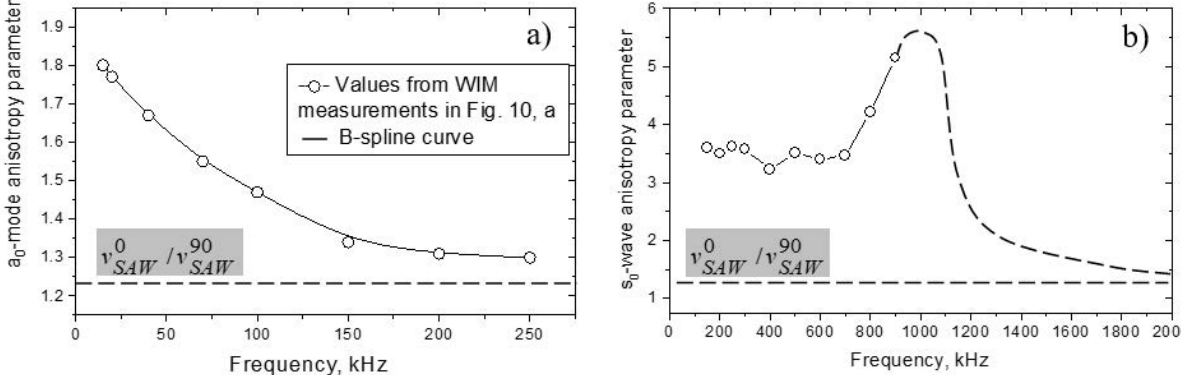
Figure 11. Anisotropy parameters for a 0 ( a ) and s 0 ( b ) modes derived from velocity measurements in Figure 10.